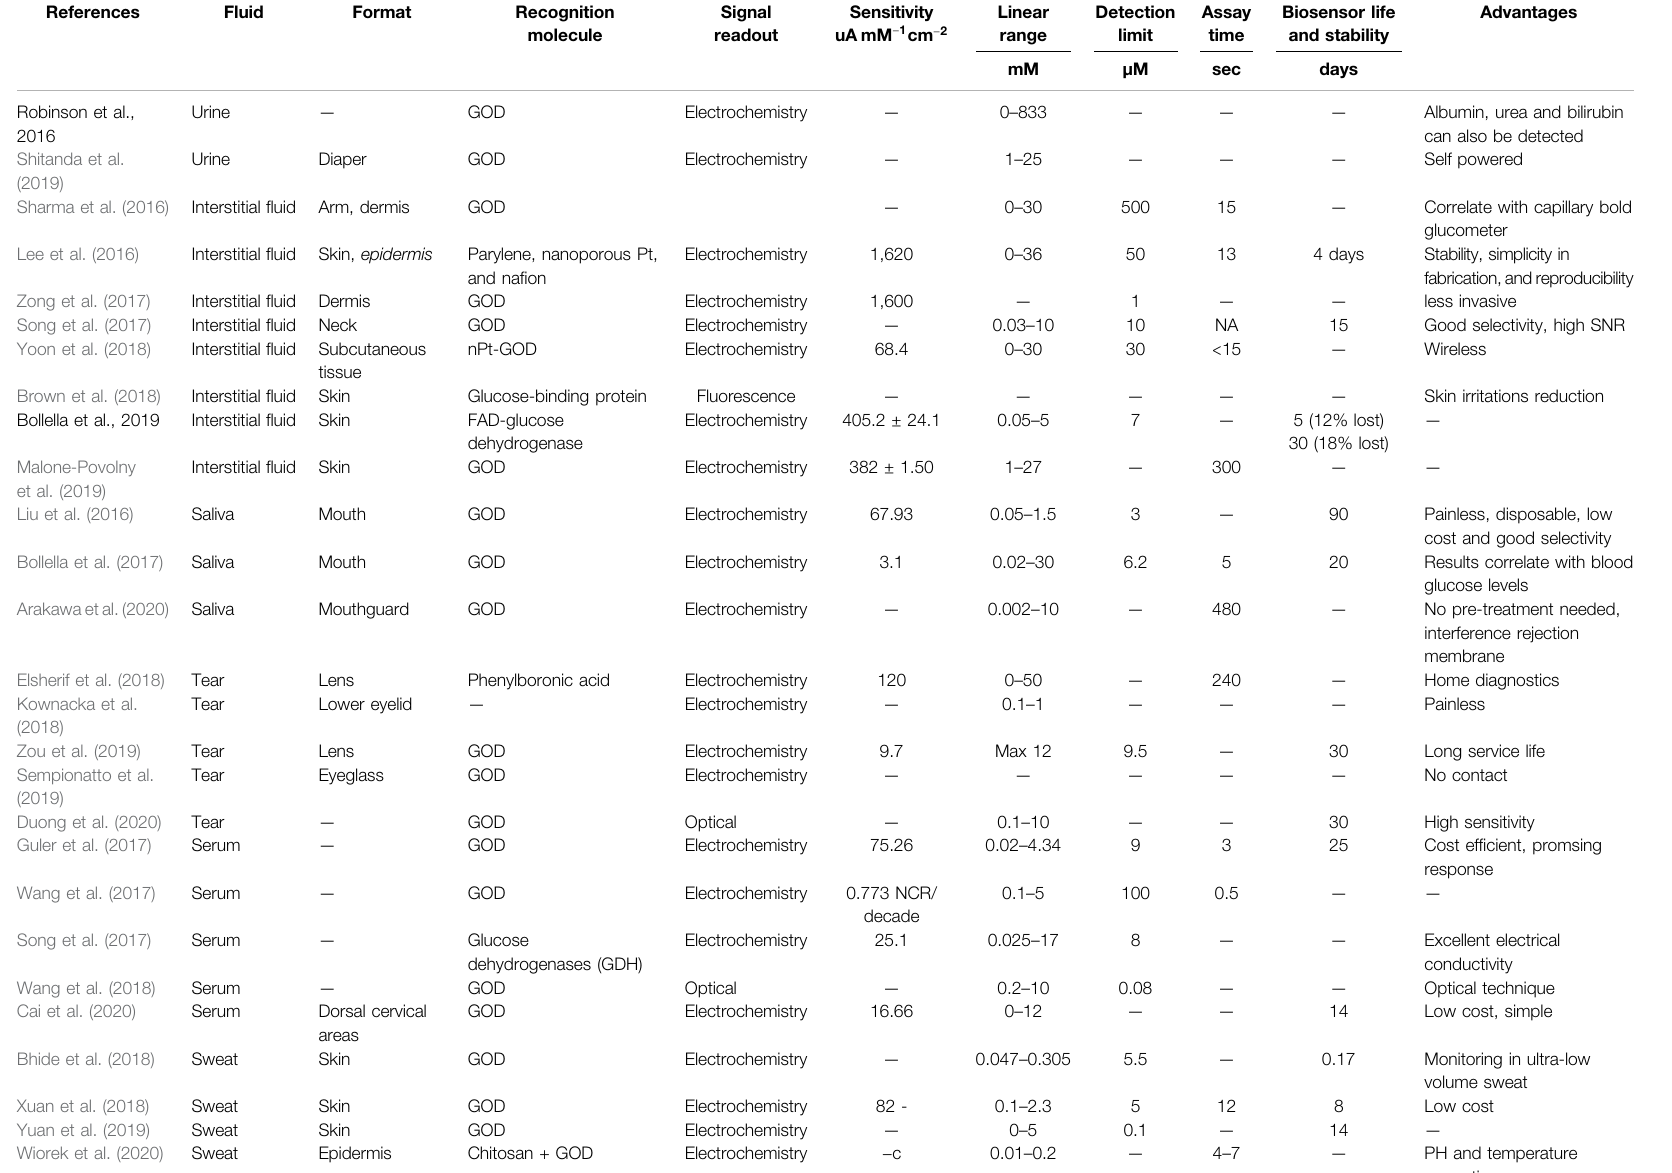
TABLE 2 | A summary of body fl uid-based continuous glucose monitoring (CGM)